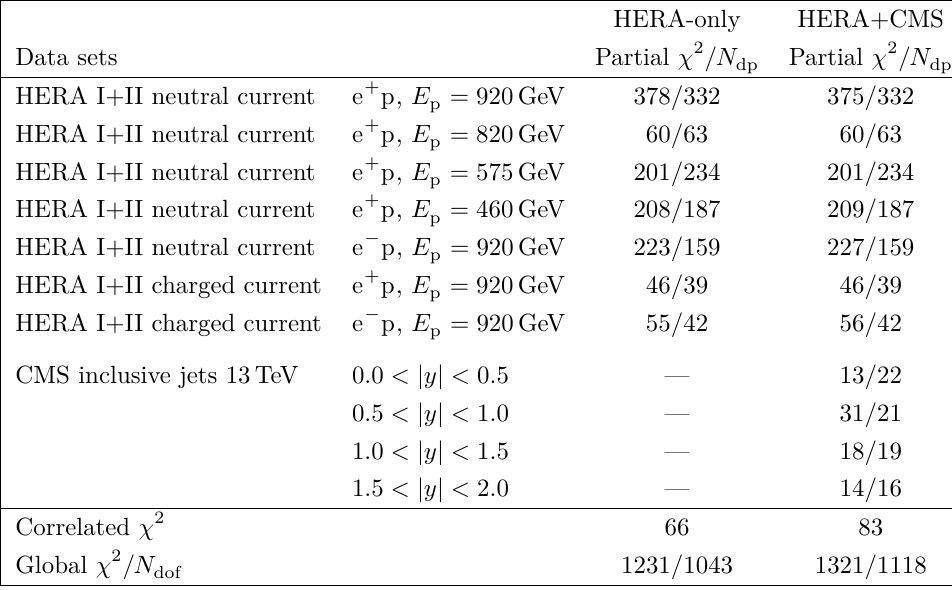
and the global χ 2 per degree of freedom, N dp and the electron energy is 27.5 p